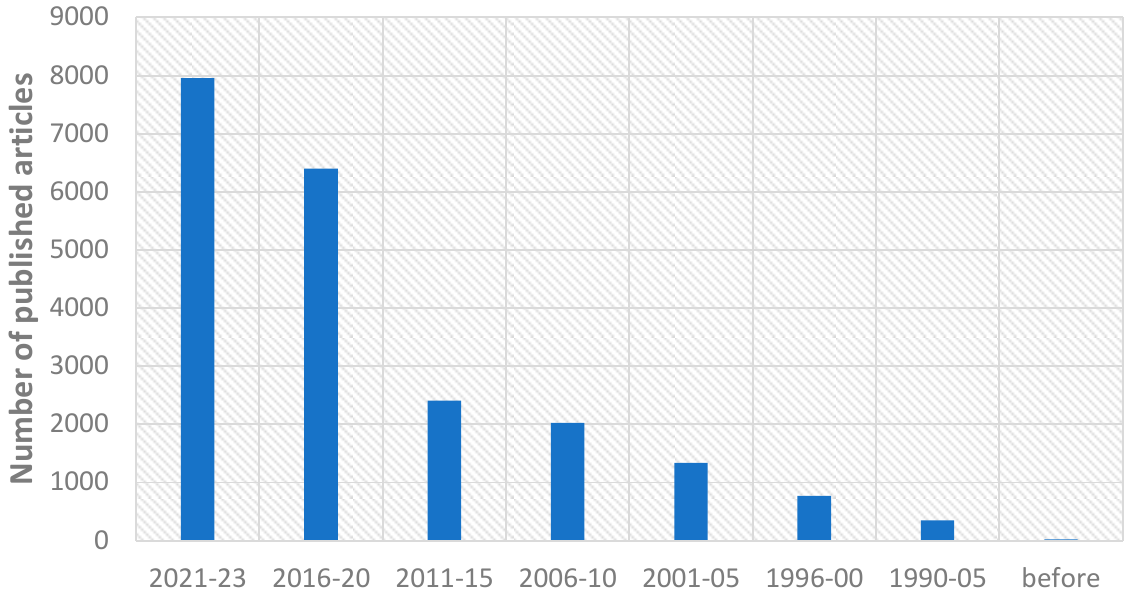
Figure 1. Published articles (in Scopus) where ANN-based models were applied to civil engineering-related subjects (until 26 December 2022).